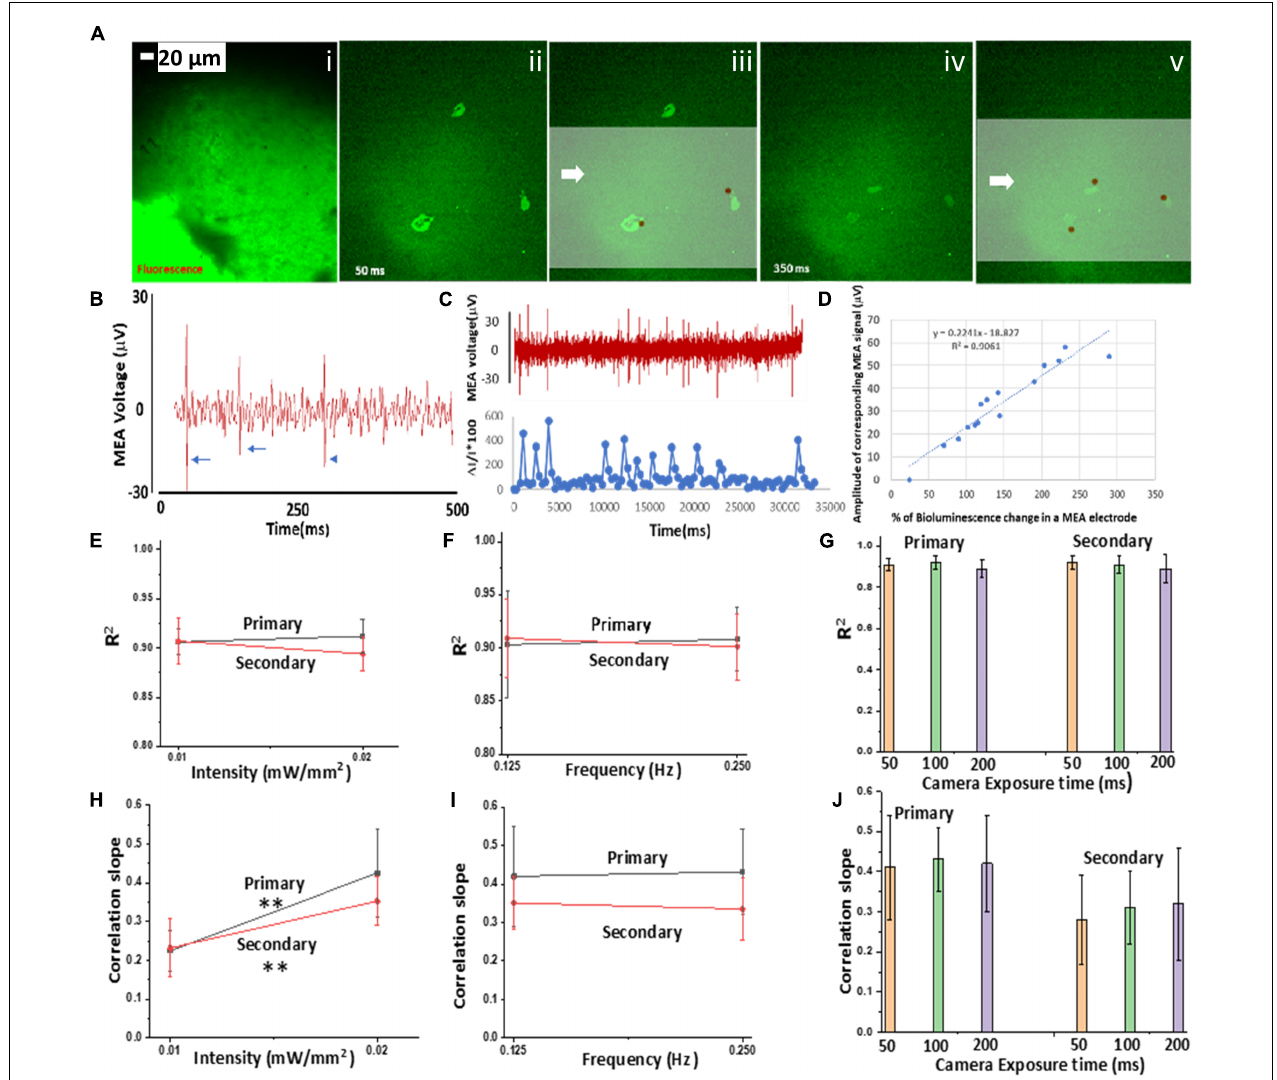
FIGURE 3 | Correlation of Ca 2 + bioluminescence and multi-electrode array (MEA) (MEA)-measured extracellular potential in bMCOII-sensitized cells upon light stimulation. (A) (i) Fluorescence image of a cortical slice on MEA; (ii–v) time-lapse images of Ca 2 + -bioluminescence signal: 50 (ii–iii) and 350 ms after (iv–v) stimulation with blue light at 470 ± 25 nm (intensity:0.5 mW/mm 2 ), superimposed on the MEA measured extra-cellular potential (brown circles). Scale bar = 20 µ m. (B) Representative voltage spikes (marked by arrows) recorded by one channel of the MEA. (C) Concomitant plot of MEA voltage ( µ V) spikes from a single MEA electrode and corresponding peaks of Ca 2 + -bioluminescence signal from a light-stimulated bMCOII-transduced neuron. (D) Correlation of% change in Ca 2 + bioluminescence signal from neurons on the MEA electrodes with amplitude of corresponding voltage spike. R 2 : Coefficient of determination of the linear correlation plot between% change in Ca 2 + bioluminescence signal and amplitude of corresponding voltage spike in MEA electrode. Dependence of R 2 on (E) light stimulation intensity, (F) frequency of light stimulation, and (G) camera exposure time for the primary and secondary responses. Variation of slope of the linear correlation between% change in Ca 2 + bioluminescence signal and corresponding voltage spike with (H) light stimulation intensity, (I) frequency of light stimulation pulses, and (J) camera exposure time. N = 3. Av. ± SD. ** p <